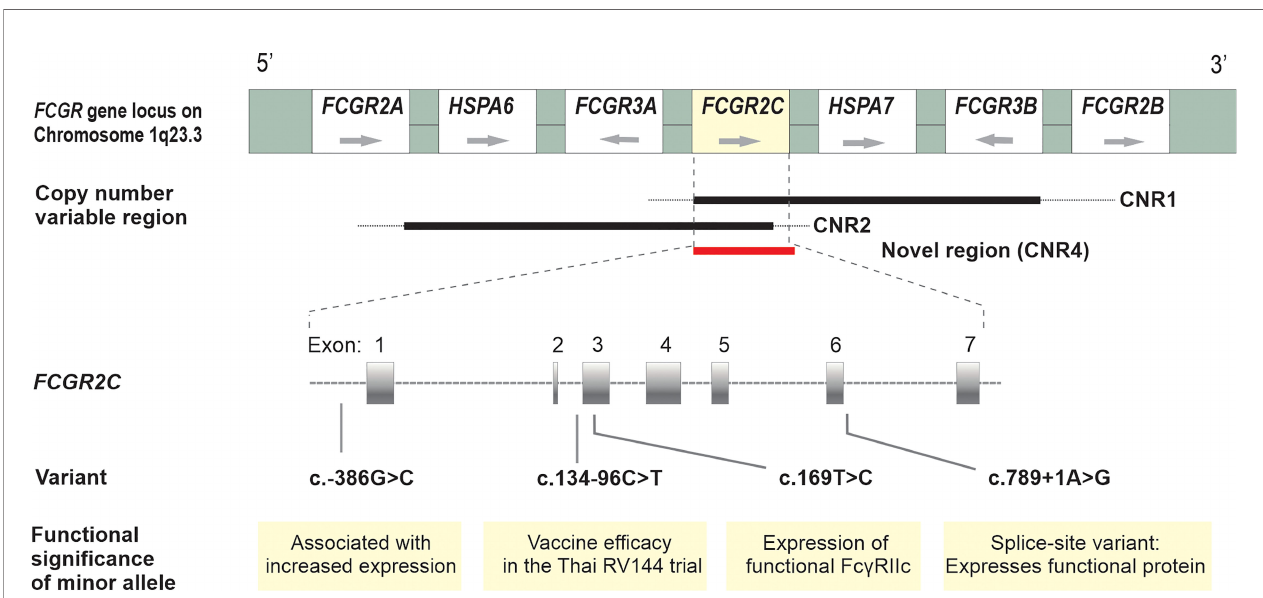
FIGURE 1 | Schematic diagram of the FCGR gene locus on chromosome 1q23 with their orientation; CNV of FCGR2C within distinct copy number variable regions – previously designated CNR1, CNR2 (8,9) and a novel region (CNR4) where only FCGR2C duplicated/deleted, as described among South African black population (12); Functional and clinically signi fi cant FCGR2C variants and their positions on the